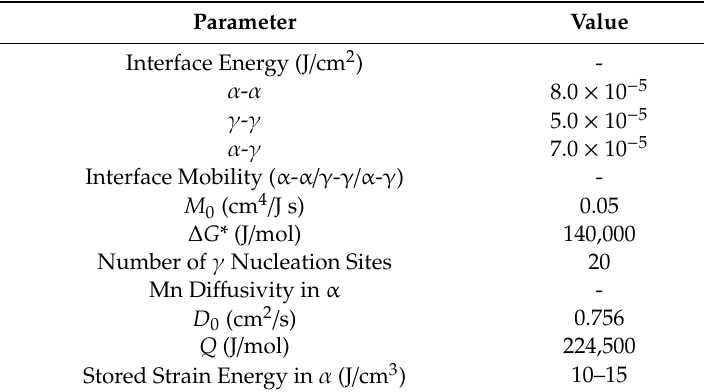
Table 1. Parameters for Initial MICRESS ®